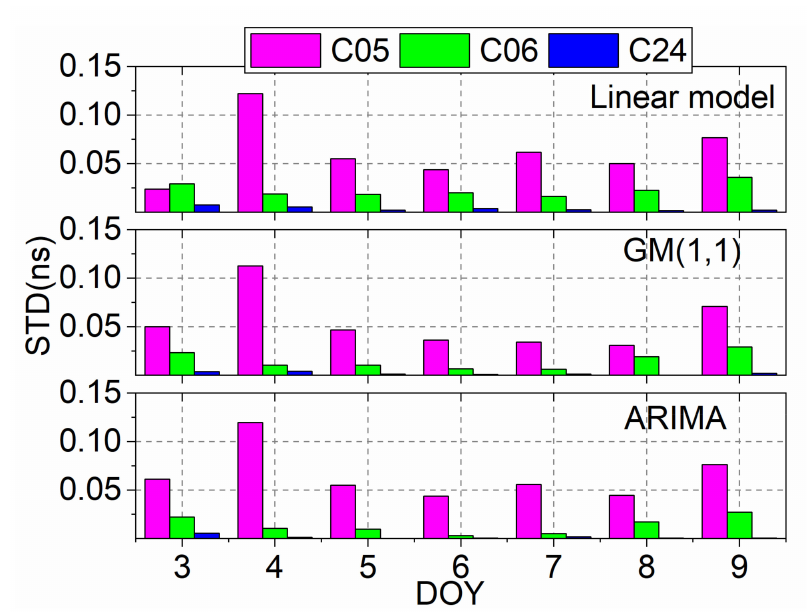
Figure 7. Daily clock STD accuracy improvement of the GEO satellite C05, the IGSO satellite C06, and the MEO satellite C24.